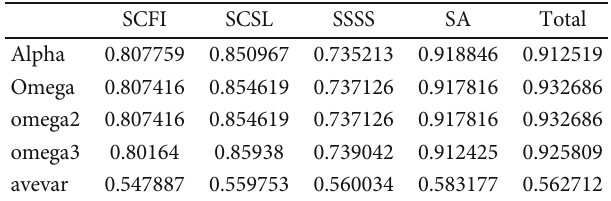
Table 4: Reliability